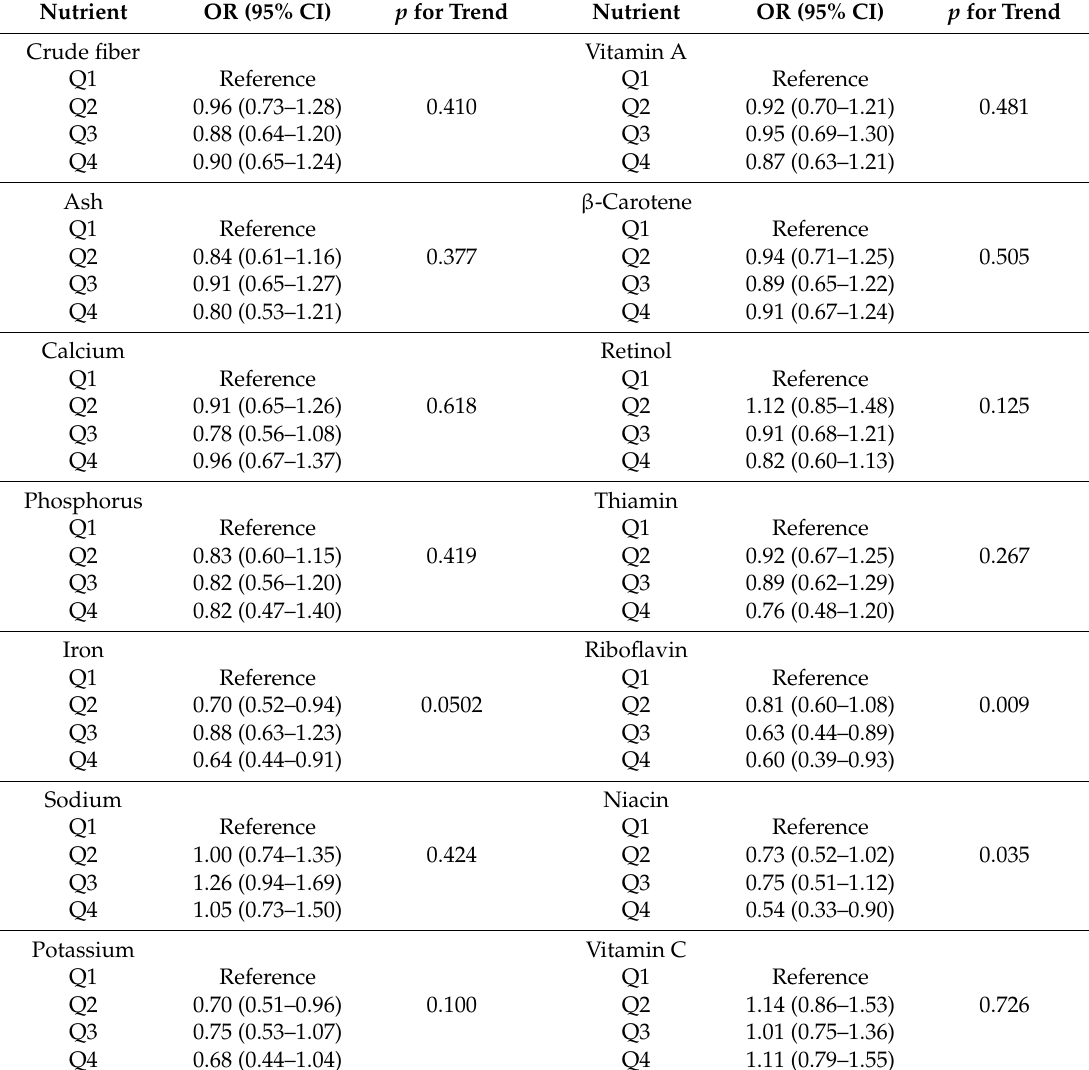
Table 7. Odds ratios of nutritional factors for glaucoma after exclusion of participants taking